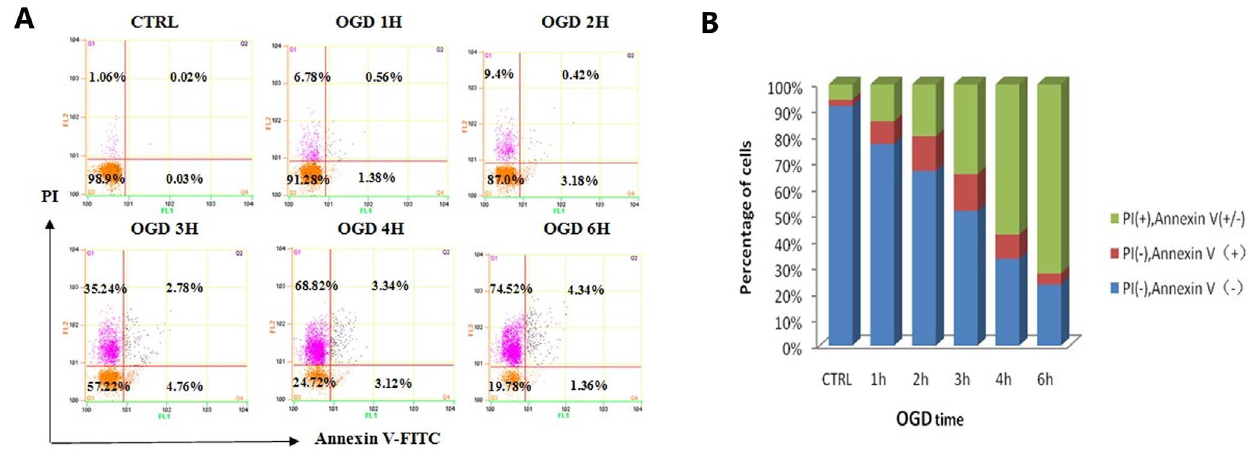
Figure 4. Detection of annexin V/PI-positive cells using FACS. ( A ) The effect of OGD on astrocyte death was quantified by detection of annexin V/PI-positive cells using FACS at different OGD time points. (B) Living (Annexin V 2 /PI 2 ), apoptotic (Annexin V + /PI 2 ) or oncotic (Annexin V + / PI + , Annexin V 2 /PI + ) astrocytes were analyzed with 3 replications.